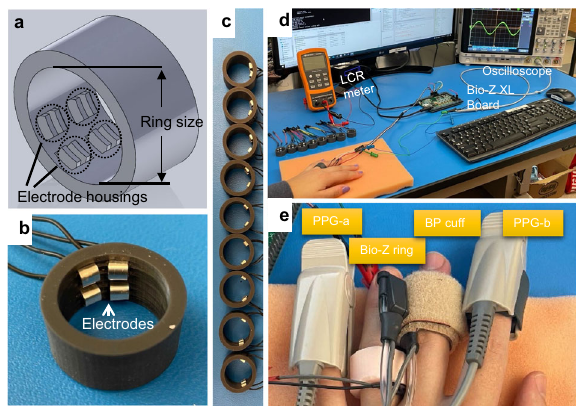
Fig. 3 Bioimpedance ring-sensor. a 3-D SolidWorks design of the ring. b An example US-7 ring with 2 mm electrode separation. c A total of nine different electrode separation rings (2 mm to 18 mm, with 2 mm step). d Experimental setup used in assessing bioimpe- dance signal quality acquired with ring sensor. Bio-Z XL board is used for bioimpedance signal acquisition with data sent to PC for post-processing through a USB communication. The LCR meter is used to ensure good electrode-skin contact prior to experimenta- tion. Oscilloscope is used to check the presence of saturation during the signal acquisition. e Different sensors on the same hand are used for blood pressure (BP) experiments. Bio-Z ring sensor is worn on the ring fi nger, with the Finapres NOVA BP cuff on the middle fi nger providing reference BP values. Photoplethysmography (PPG) sensors, PPG-a and PPG-b, are connected to the Bio-Z XL board and Finapres NOVA device respectively, and used for synchronization of BP beats with ring sensor bioimpedance features.